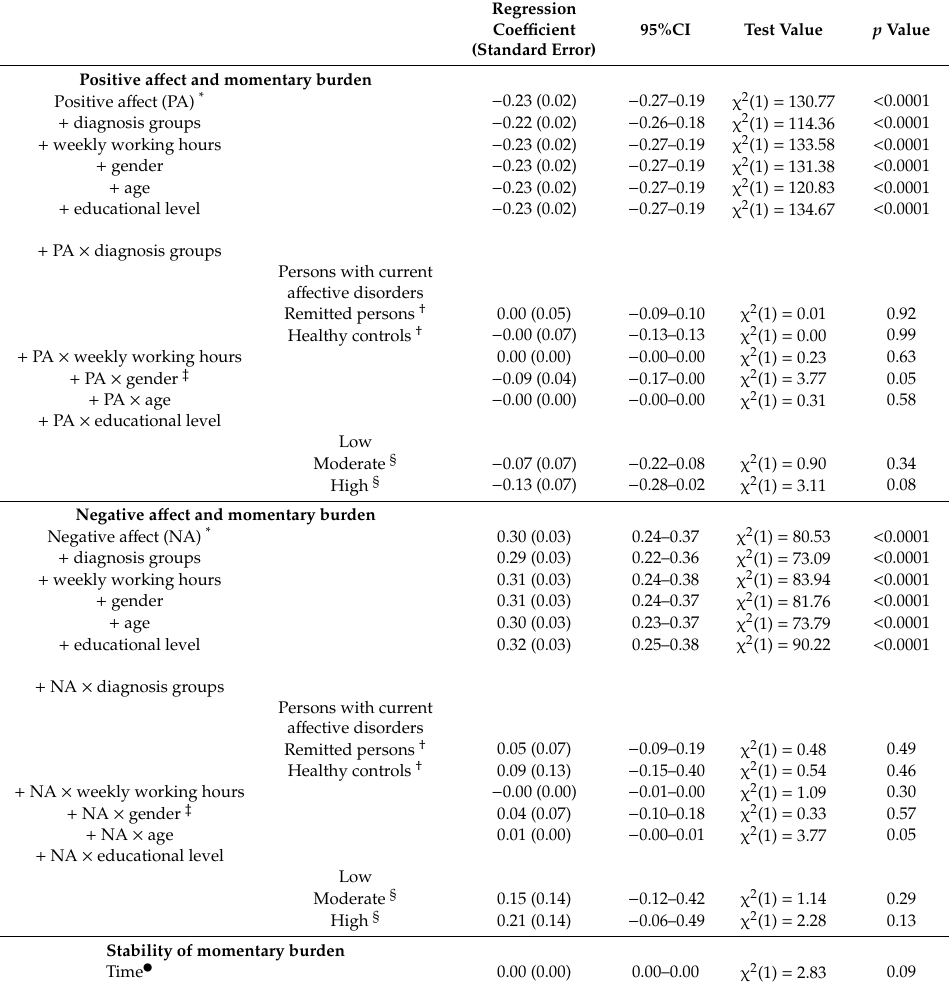
Table 2. Association between momentary burden, a ff ective scales and